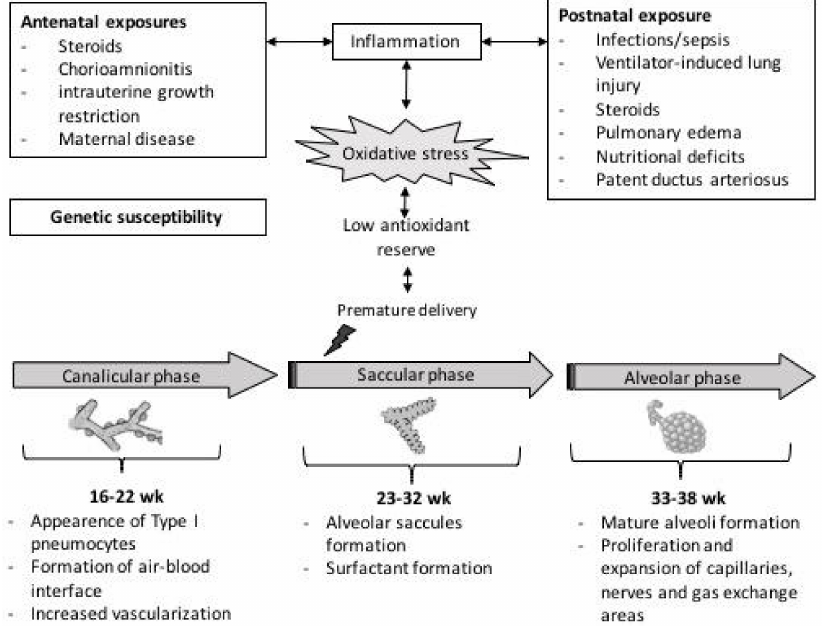
Figure 1. Schematic representation of mechanisms involved in free-radical mediated lung diseases following preterm